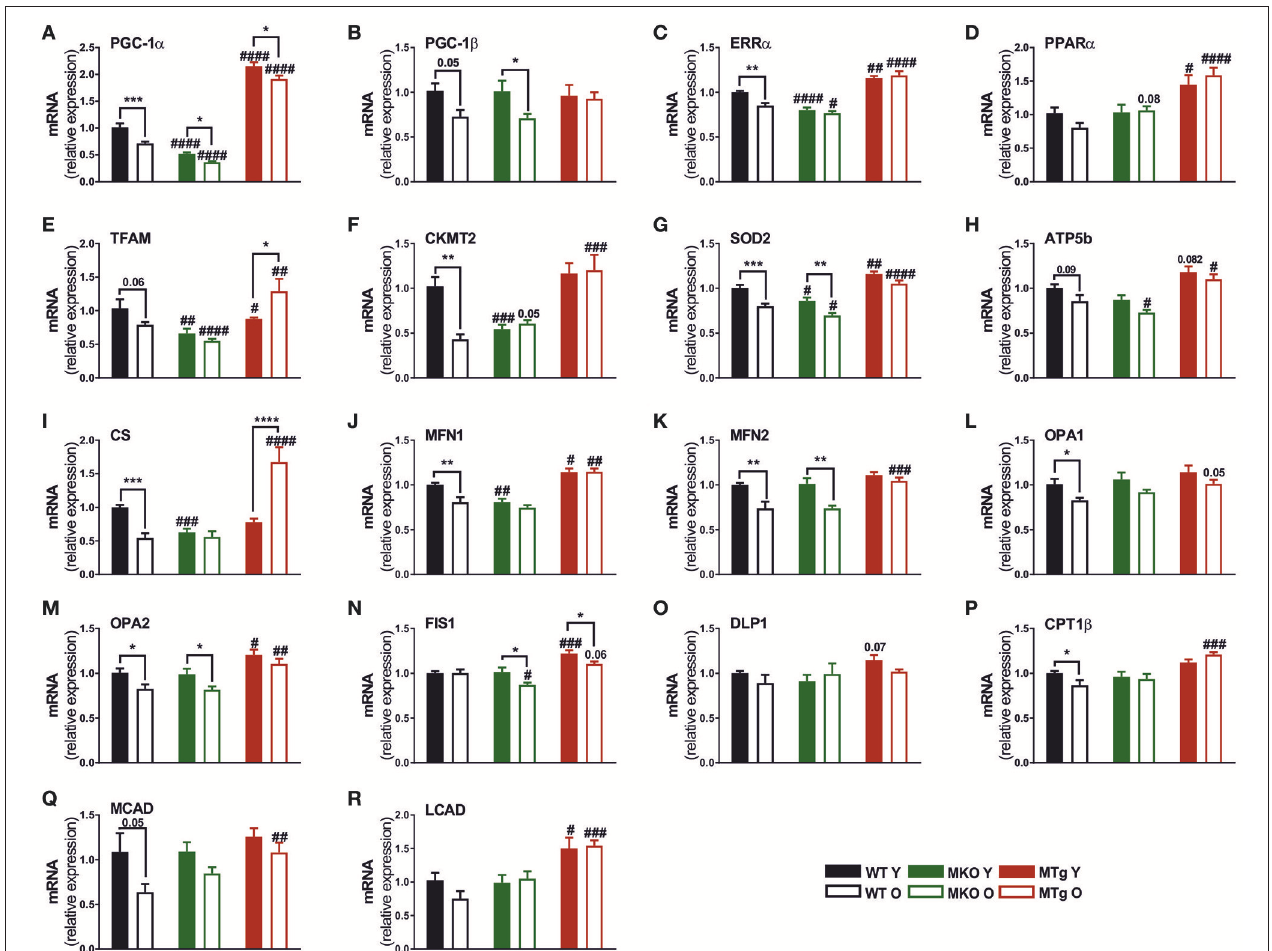
FIGURE 3 | PGC-1 α overexpression protects against the age-related reduction of genes involved in mitochondrial biogenesis, dynamics, oxidative phosphorylation and fatty acid oxidation . (A–F) Gene expression profile of genes involved in mitochondrial biogenesis and function ( n = 6/group). (G–I) Gene expression levels of mitochondrial superoxide dismutase (SOD2), OXPHOS and TCA cycle genes ( n = 6/group). (J–M) Mitochondrial fusion gene expression profile ( n = 6/group). (N,O) Mitochondrial fission gene expression profile ( n = 6/group). (P–R) Fatty acid β -oxidation (FAO) gene expression profile. Data are means ± SEM of values from each group. Significant age/genotype-associated differences ( p < 0.05) are indicated by asterisks (*) and by hashtags (#, compared to WT) respectively (*/#: p < 0.05; **/##: p < 0.01; ***/###: p < 0.001; ****/####: p < 0.0001 indicates age/genotype related significant differences). ATP5B ATP synthase, H + transporting, mitochondrial F1 complex, beta polypeptide; CKMT2, creatine kinase, mitochondrial 2; CPT1 β , carnitine palmitoyltransferase 1 β ; CS, citrate synthase; DLP1, dynamin-like protein 1; FIS1, fission, mitochondrial 1; LCAD, long chain acyl-CoA dehydrogenase; MCAD, medium chain acyl-CoA dehydrogenase; MFN,